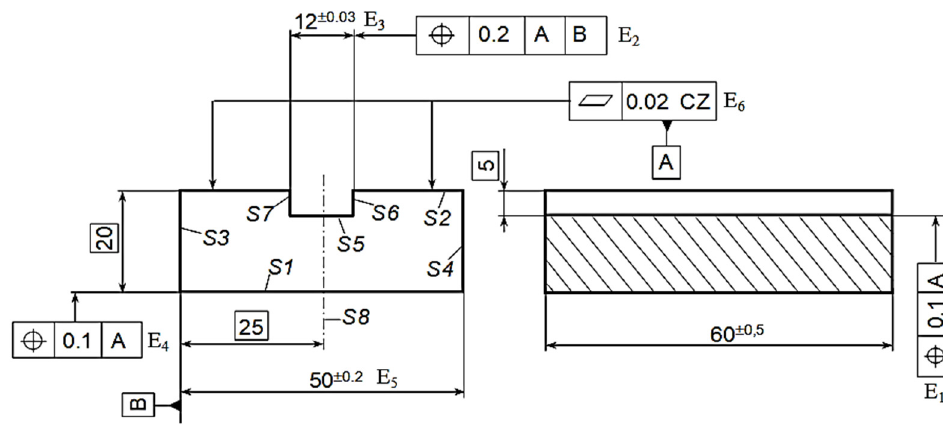
Figure 5. Functional definition drawing.